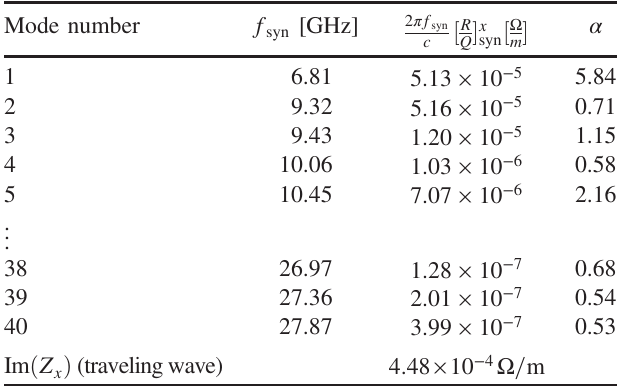
TABLE VII. Transverse traveling wave data for one period of the FCC-hh beam screen depicted in Fig. 1. The final result for Þ is the sum of the elements of the third column weighted Im ð Z x with the corresponding factors α